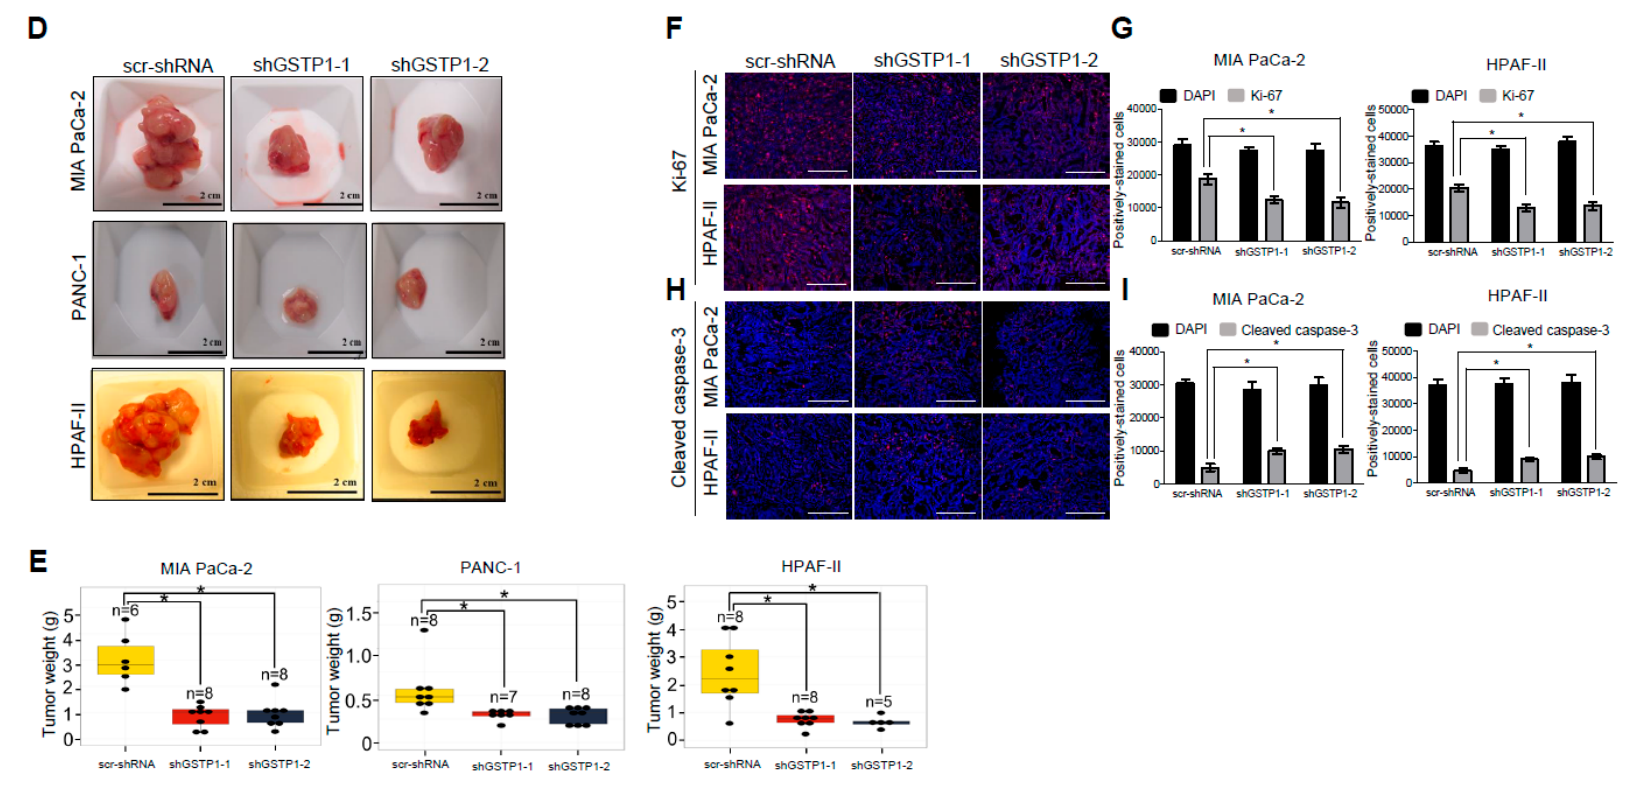
Figure 6. GSTP1 knockdown impedes the growth and proliferation of PDAC cells in vivo. ( A ) Schematic representation of animal experiments to assess the effects of GSTP1 knockdown on PDAC (MIA PaCa-2, PANC-1, or HPAF-II) tumor growth in nude mice for up to 42 days (D42). US1-3: ultrasound imaging was performed every 10 days to monitor tumor growth. For the HPAF-II group, the last ultrasound was done on D27 rather than D30. ( B ) Pancreatic tumor development was monitored and imaged using the FUJIFILM Vevo3100 ultrasound imaging system. The data show the tumor volume for one representative mouse for each group measured at US3 soon before euthanasia. Blue: healthy pancreatic tissue, white: pancreatic tumor tissue. ( C ) Total pancreata volumes were calculated using 3-dimensional ultrasound images for each cell line using the data collected at US3. ( D ) Size and ( E ) weight of the pancreata are shown for control and GSTP1 knockdown tumors. The figures show representative images of the tumor volumes (ultrasound) and tumor sizes of various treatment groups. The tumor volume and weight were compared